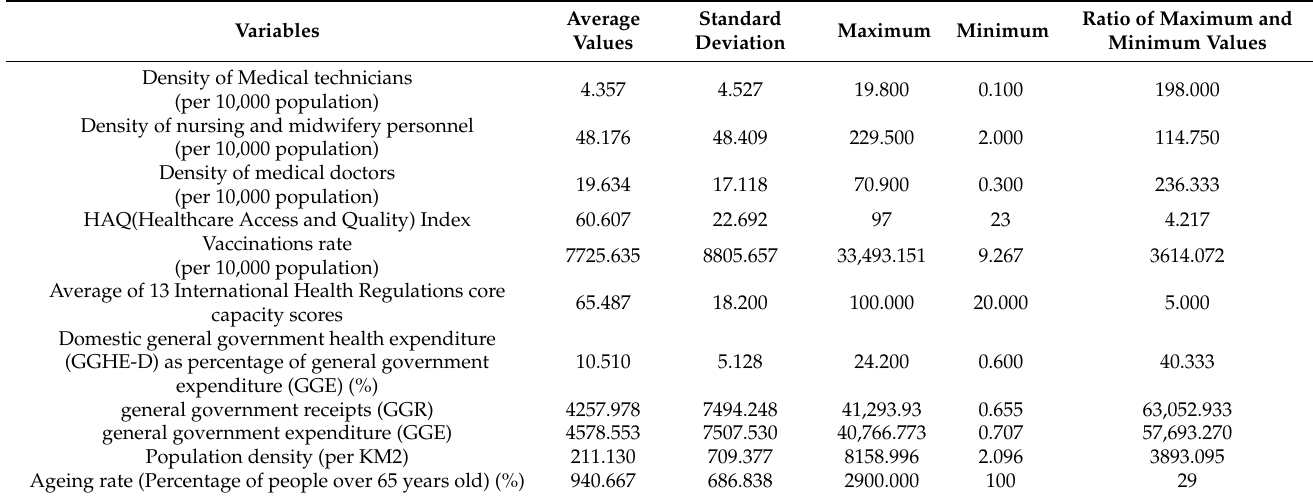
Table 6. Descriptive statistics of HRCC indicators for 150 countries worldwide.